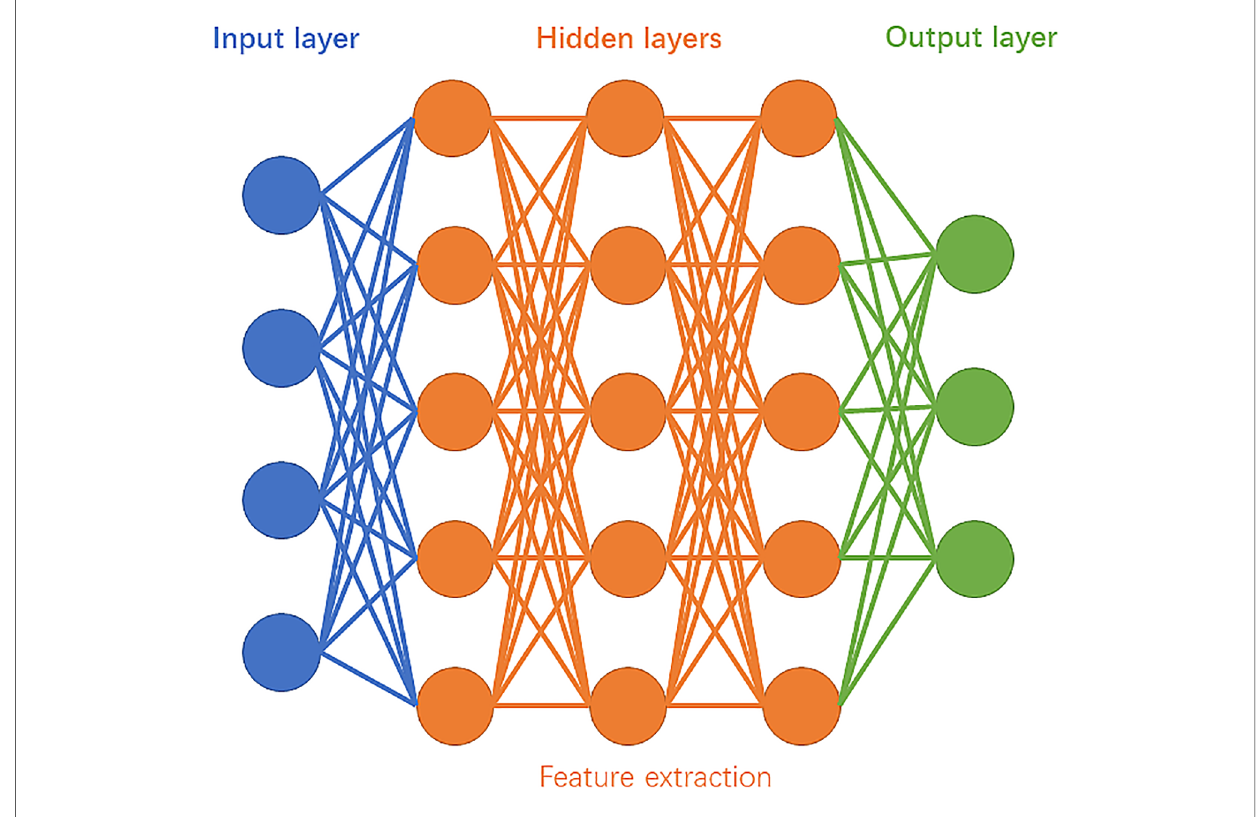
FIGURE 2 Schematic diagram of deep